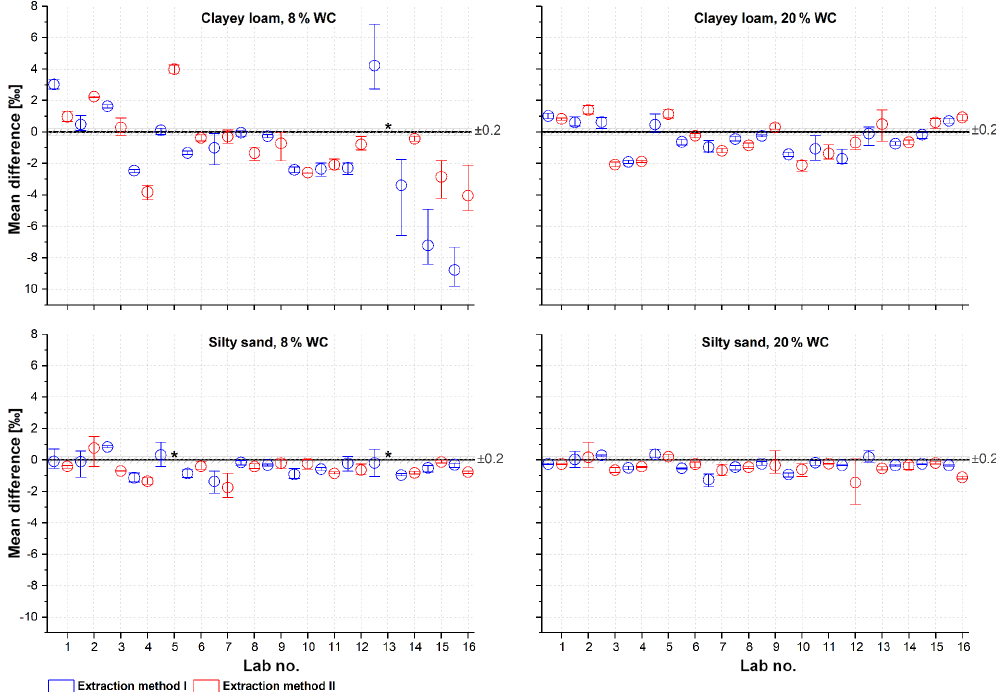
Figure 4. Mean differences from reference DI water for δ 18 O OA-ICOS results of water extracts from both extraction methods (lab procedure: I; predefined: II), soil types, and water contents (8 and 20%WC) including TSD of ± 0.2 for δ 18 O. Asterisks represent outliers. Symbols represent the mean of the three replicates and y error bars stand for the isotopic variation of the replicates. There were no significant differences between the two extraction approaches over all